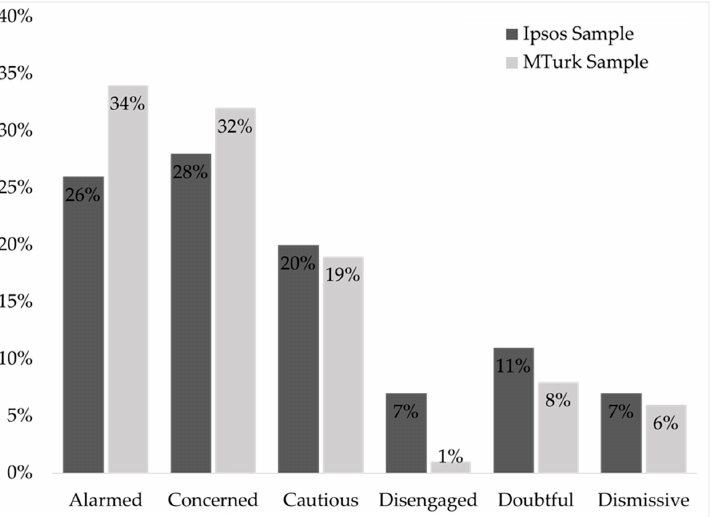
Figure 1. Ipsos National Estimates, April 2020 vs. MTurk Group Data, July–August 2020.